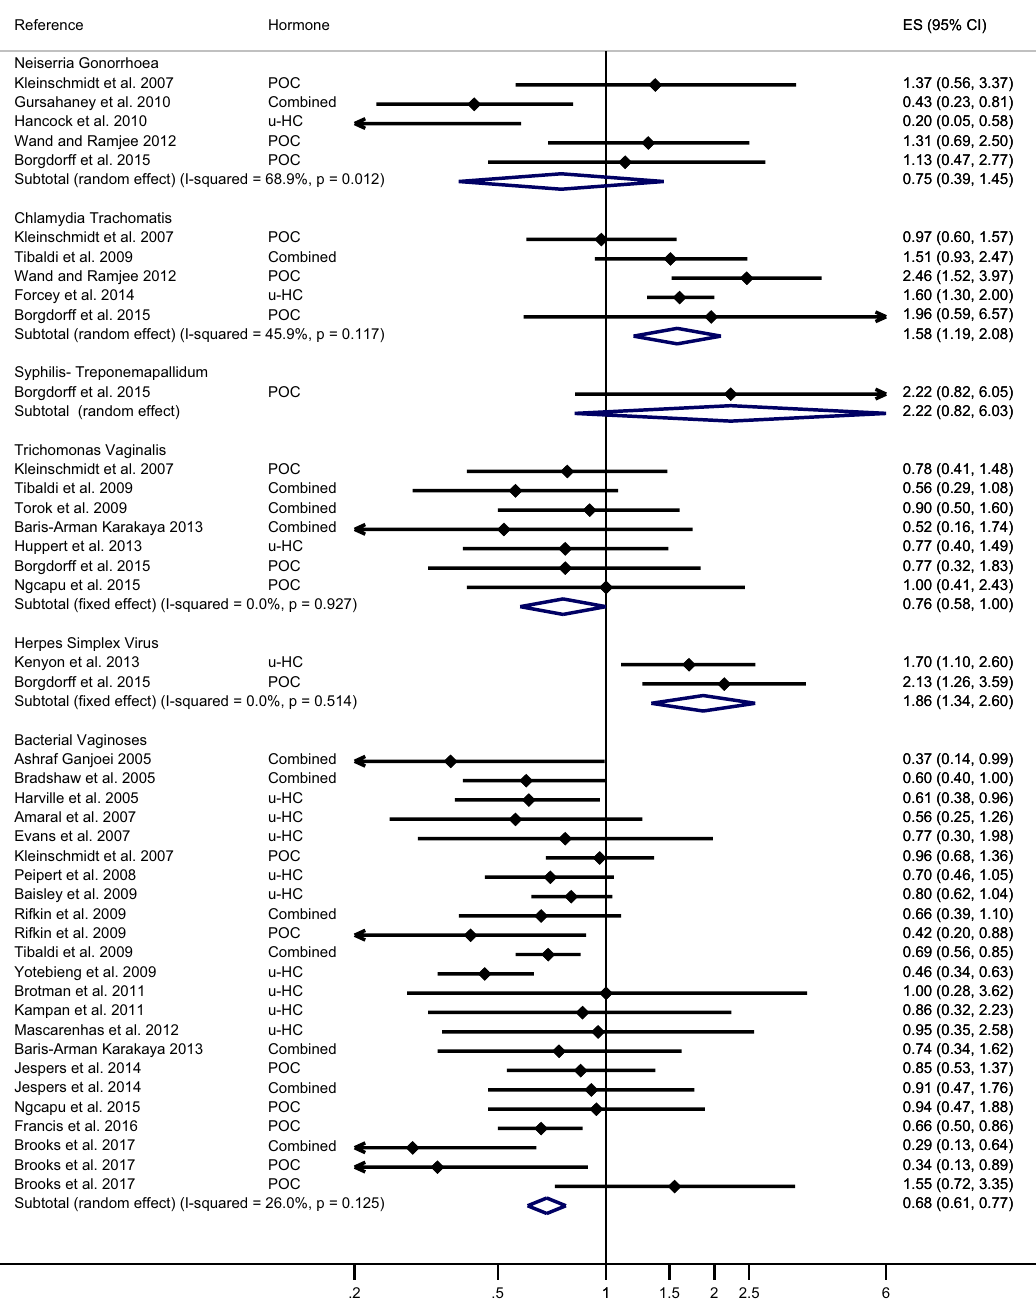
and the composite outcome of STIs showed an approximately symmetrical distribution with no indication of publication bias (Egger’s Bias coefficient = − 0.11, 95% CI − 0.81, 0.60, p = 0.76). The funnel plots for prevalent STIs also indicated an almost symmetrical distribution with the extinction of publication bias (Egger’s Bias coefficient = − 0.31, 95% CI − 1.55, 0.93, p = 0.61). The third funnel plots for incident STIs indicated a little asym- metry but we did not observe any significant indication of publication bias (Egger’s Bias coefficient = 1.68, 95% CI: − 0.27, 3.63, p = 0.10). We also conducted funnel plots using estimates within the individual STIs (Fig. 6). The association of HC-use with CT (Egger’s Bias coefficient = − 0.69, 95% CI − 4.21, 2.83, p = 0.65), TV (Egger’s Bias coefficient = − 0.83, 95% CI − 1.70, 0.03, p = 0.06), and BV (Egger’s Bias coefficient = − 0.48, 95% CI − 1.14, 0.19, p = 0.15) showed